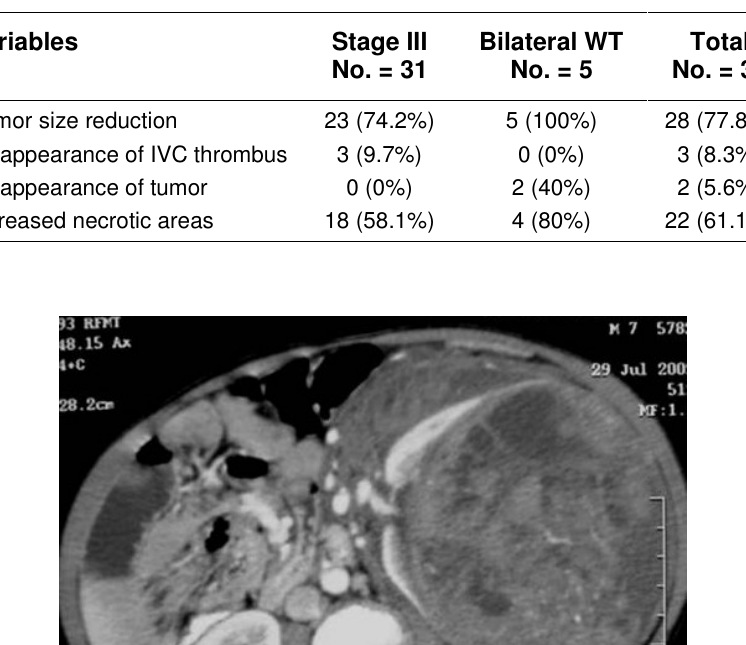
Response to Preoperative Chemotherapy as Evaluated by CT